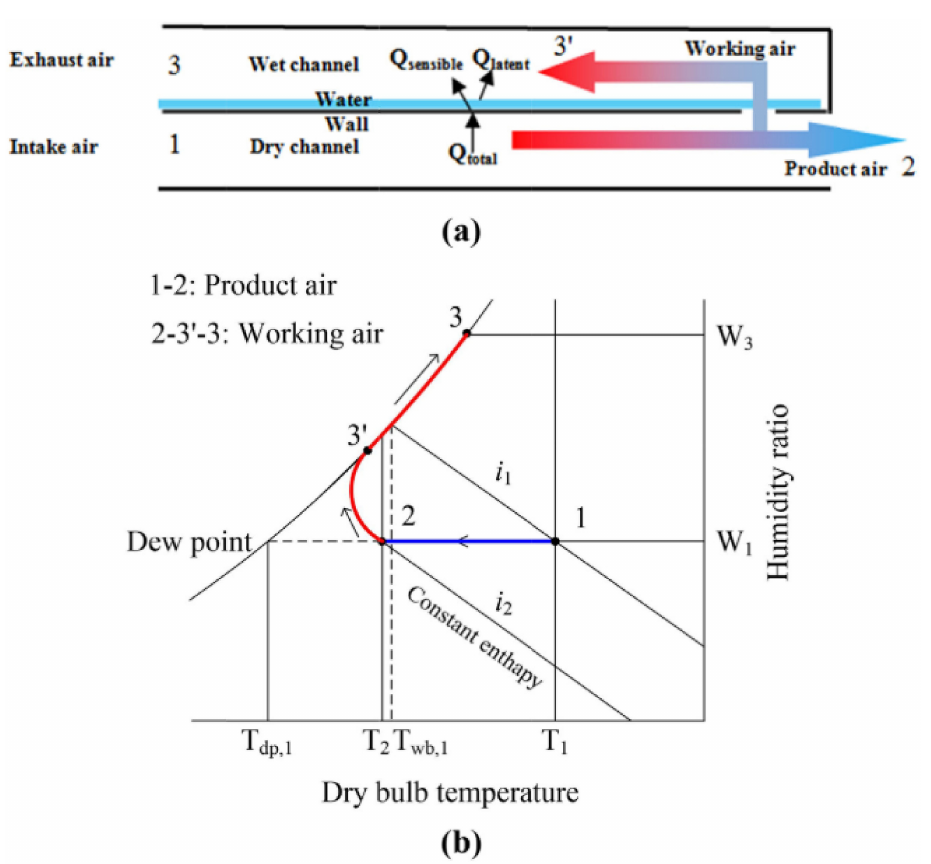
Figure 3. ( a ) Working diagram of M-cycle IEC; ( b ) Working process of M-cycle IEC in psychrometric diagram